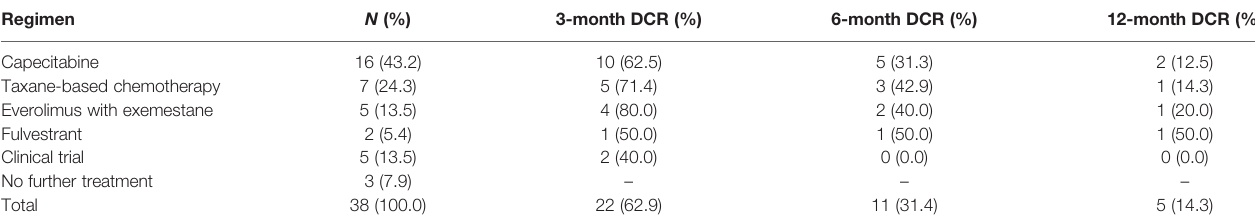
TABLE 5 | Second-line treatment after progression from endocrine therapy with palbociclib and letrozole ( N = 38). Regimen N (%)